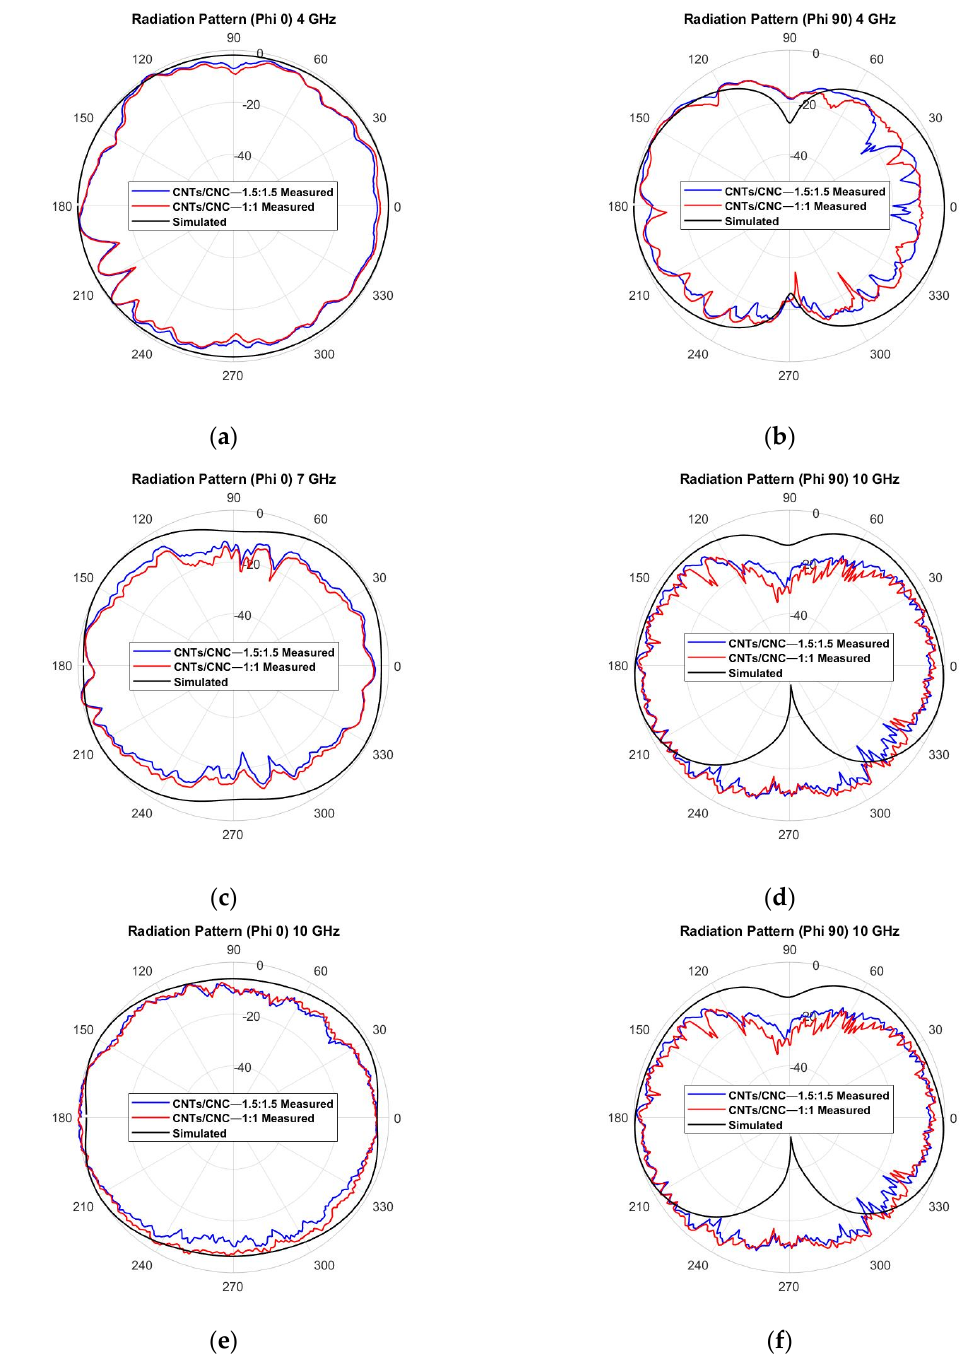
Figure 16. Measured vs. simulated radiation pattern of the graphene-based textile PICA antenna in free space, E -plane cut at φ = 90° and H -plane cut at φ = 0°, for the three main frequencies: ( a , b ) 4 GHz; ( c , d ) 7 GHz; ( e , f ) 10 GHz.